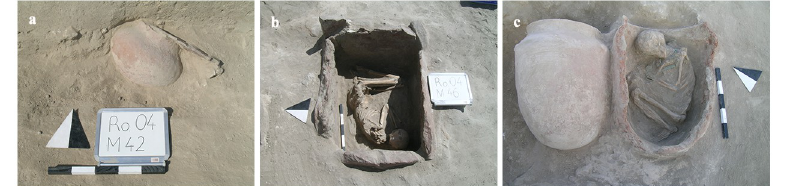
Fig 5. Examples from burial practices in the Resulo ğ lu cemetery: a) jar grave, b) cist grave, c) pithos grave ( © Resulo ğ luexcavations archive).